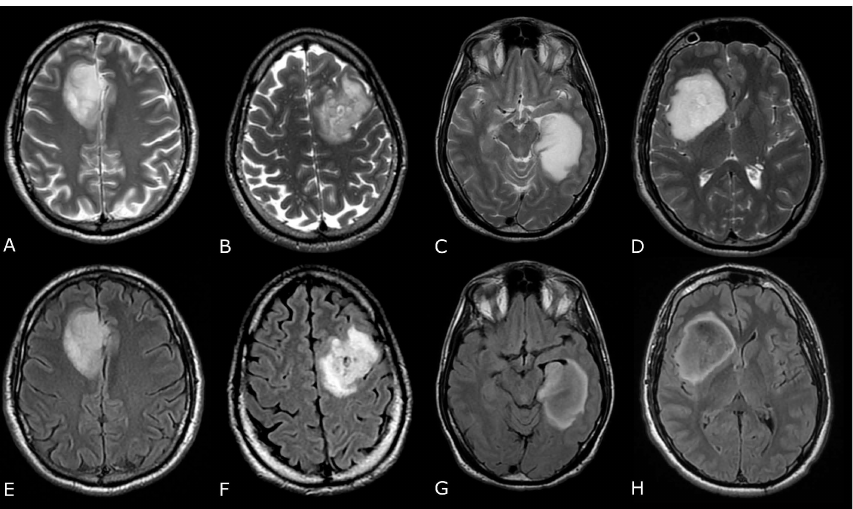
Figure 3. T2/FLAIR Mismatch Sign. Upper Row Ax T2w images, Lower Row Ax T2-FLAIR images. ( A , E ); ( B , F ) IDH-mut, 1p-19q codeleted ODs, respectively grade 2 ( A , E ) and grade 3 ( B , F ). ( C , G ); ( D , H ) IDH-mut, 1p-19q non codeleted Diffuse Astrocitomas, respectively grade 2 ( C , G ) and grade 3 ( D , H ). The T2-FLAIR mismatch sign ( C ) vs. ( G ) and ( D ) vs. ( H ) represents the T2 signal